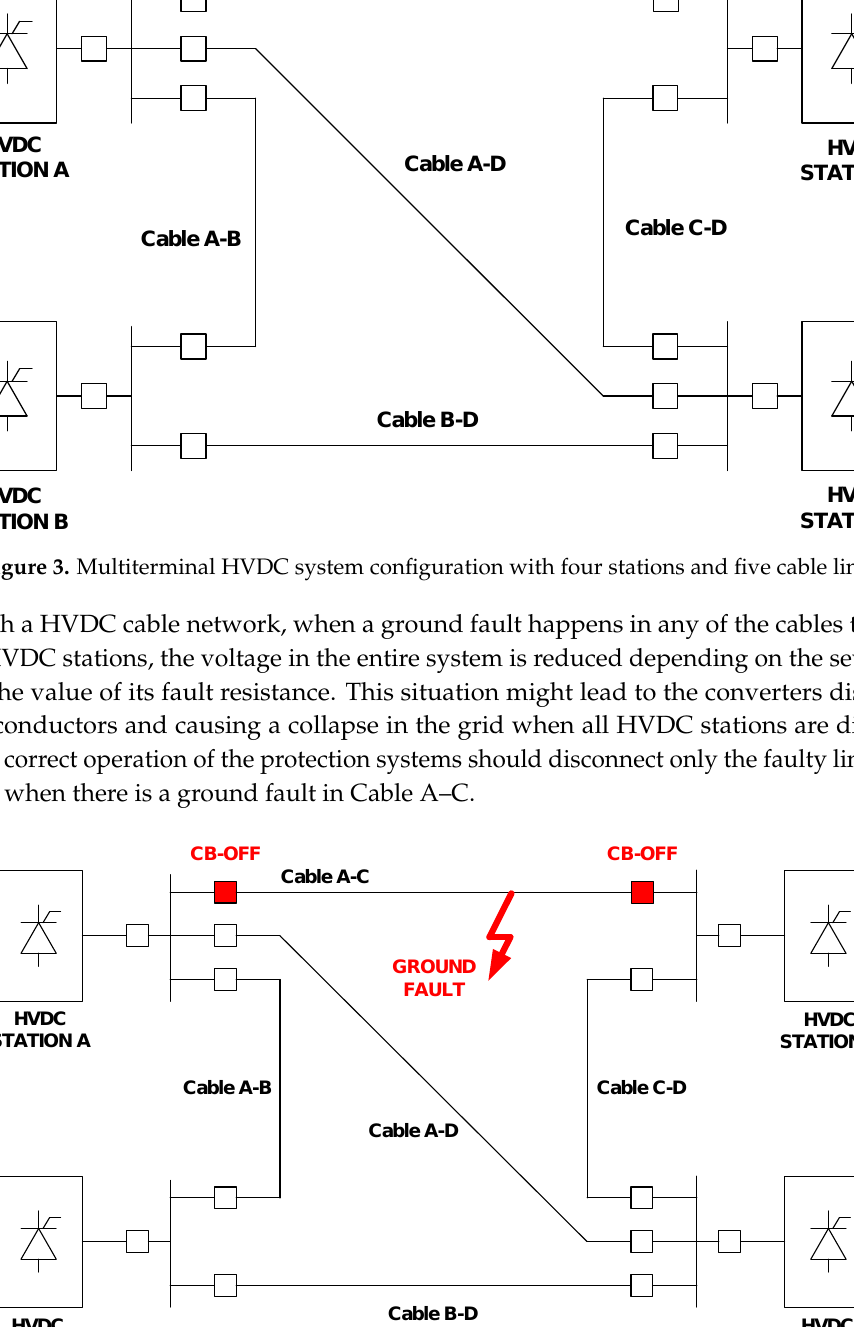
Figure 2. HVDC transmission line versus high-voltage alternating current (HVAC) transmission line.